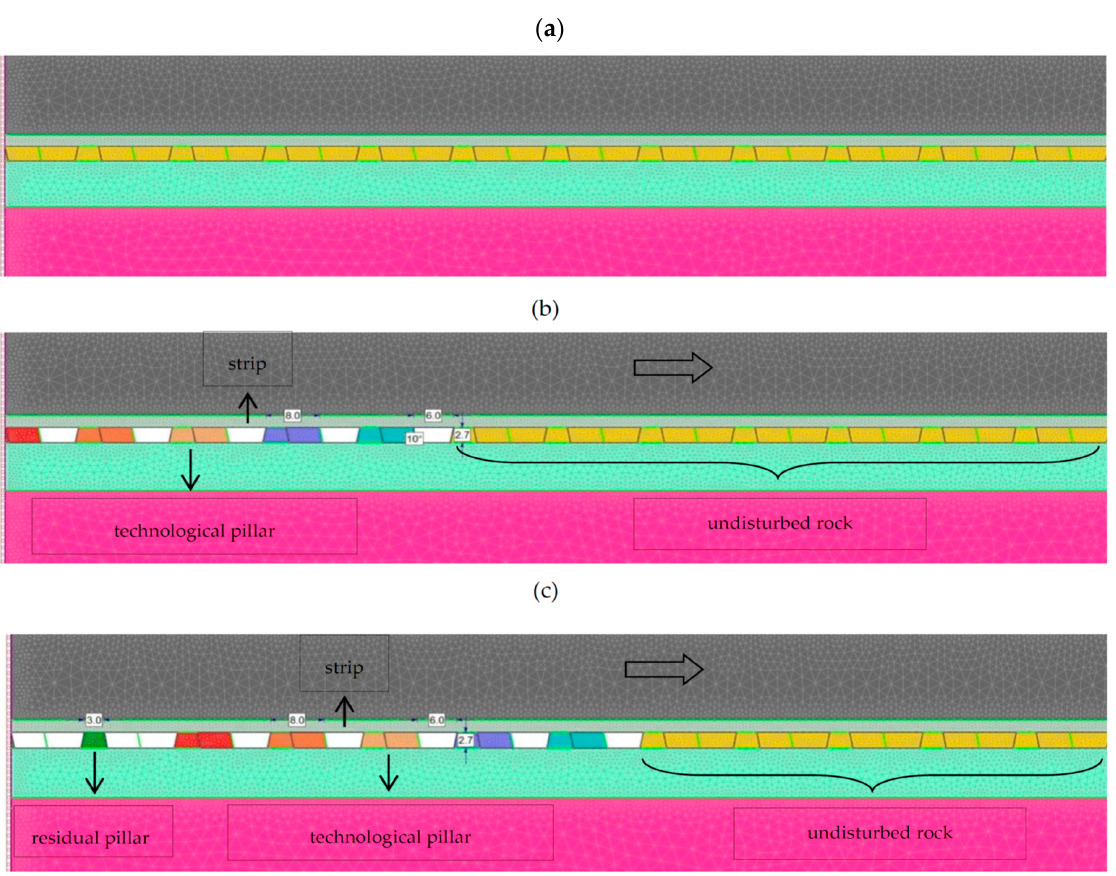
Figure 6. Simulation of room and pillar mining in the analyzed field: ( a ) step 1, ( b ) step 2, ( c ) step 4. Table 1. Averaged geomechanical parameters of rock.